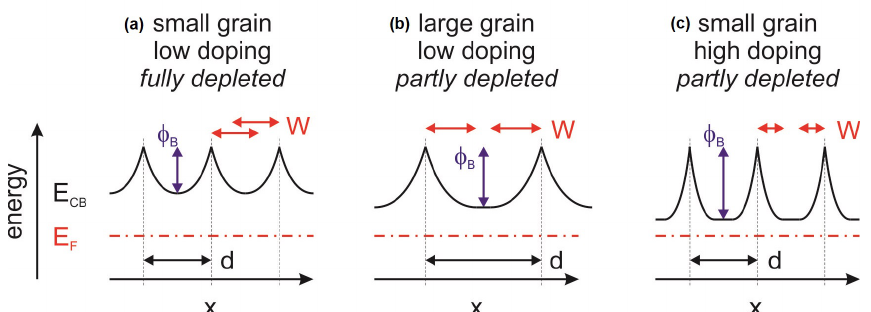
Figure 3. Energy band diagrams of n-type polycrystalline semiconductors with depleted electron concentrations in the space charge layers at grain boundaries. Positions of grain boundaries are indicated by dashed vertical lines. For small grains ( a ), when the width of the space region W exceeds half of the distance between neighboring grain boundaries ( d < 2 W ), the potential profiles of neighboring grain boundaries overlap as indicated by the red arrows. The width of the space charge region is ∼ 5nm for a doping concentration of 10 20 cm − 3 . The potential barrier at the grain boundary, φ B , which corresponds to the band bending, increases with grain size ( b ) or doping concentration ( c ). Smaller grains can therefore, exhibit lower effective carrier concentrations and higher carrier